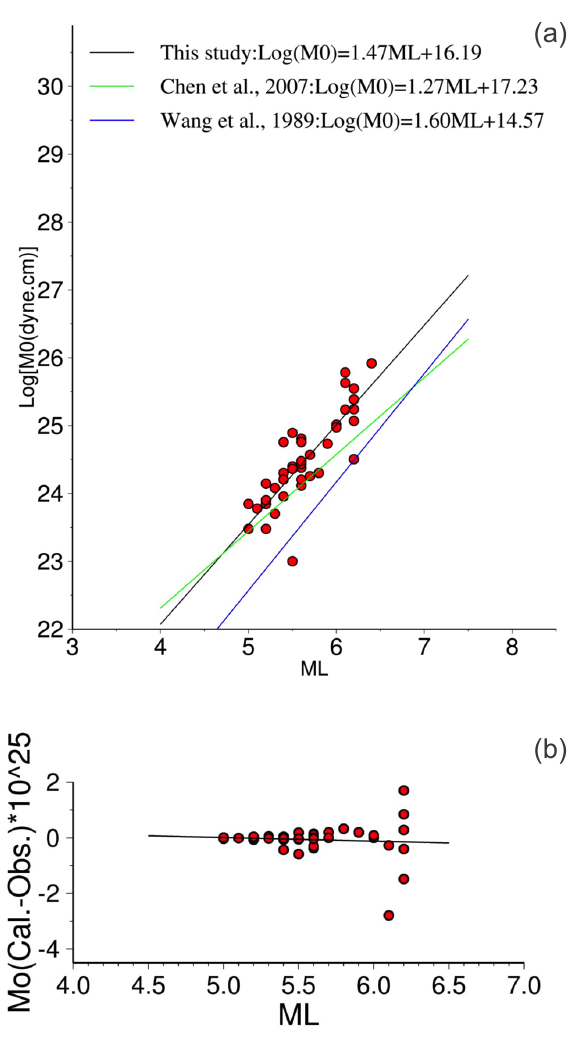
and M in Iran. W N